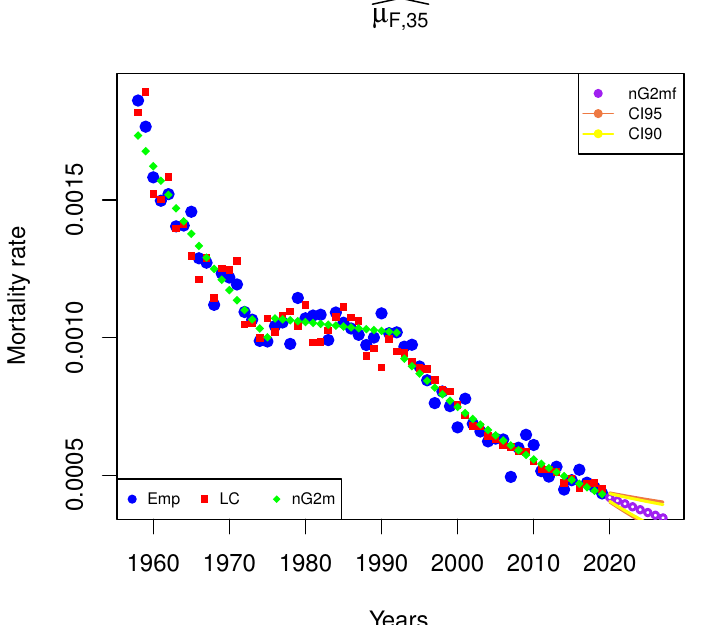
Figure 5. The values of mortality rates—male, age 37: empirical (Emp), theoretical (LC, nGs), forecasts (nGsf), and c. interval based on the LC, and nGs model with switch.